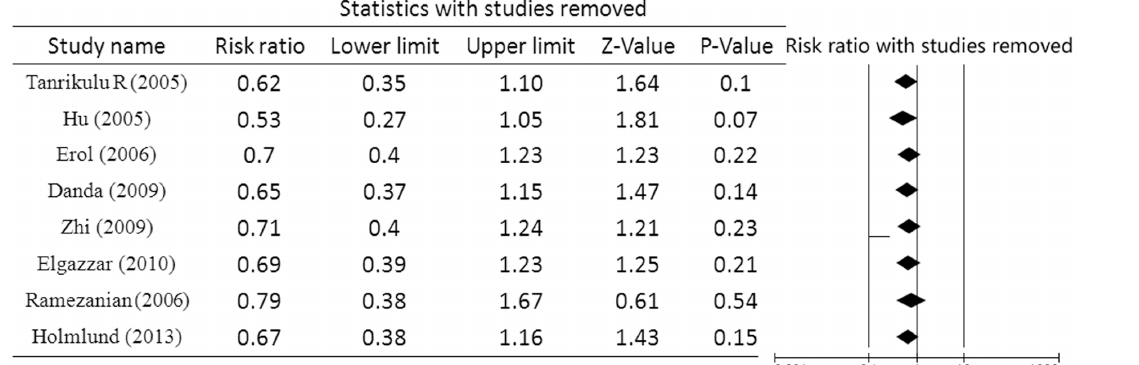
PLOS ONE | DOI:10.1371/journal.pone.0127652 May 26,